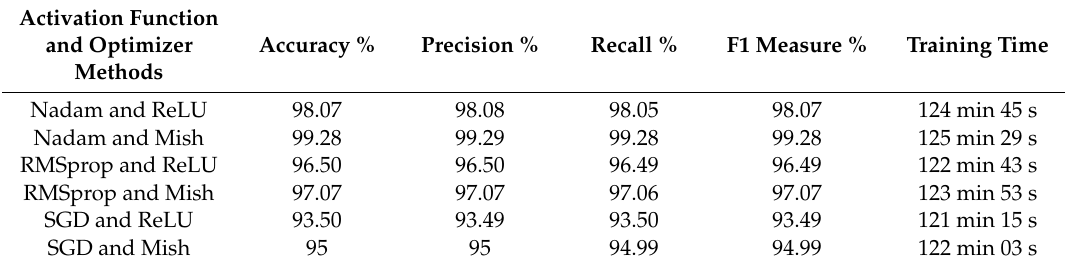
Table 5. The performance of Xception with ReLU and Mish combined with other optimizers.